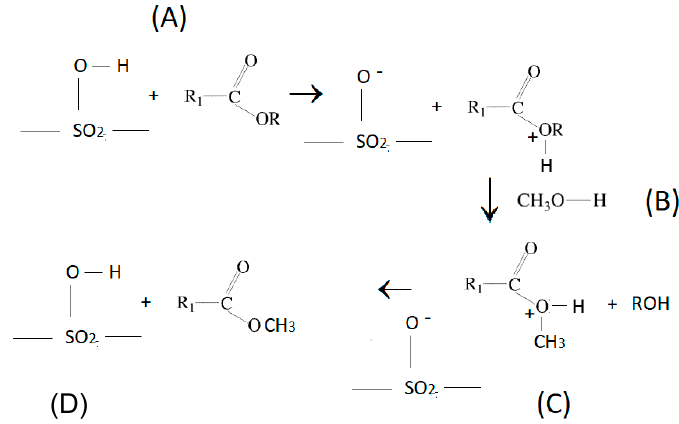
Figure 4. Transesterification reaction scheme over acid biochars catalysts, where –SO 3 H is a surface acid site.